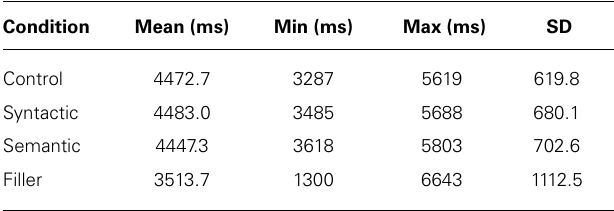
Table 1 | Mean articulatory length of the 184 stimuli used in the